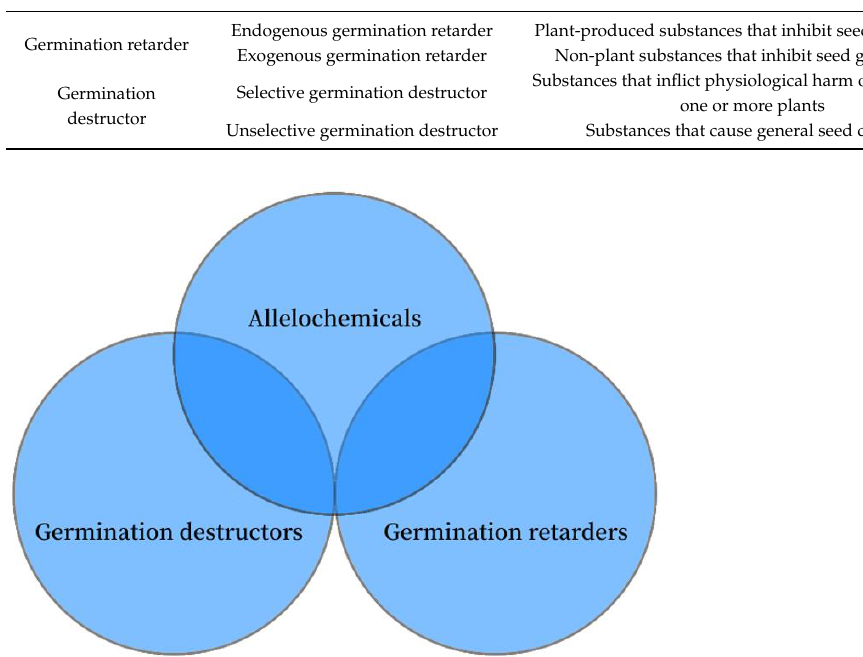
Figure 1. Relationship between germination retarders, germination destructors and allelochemicals.